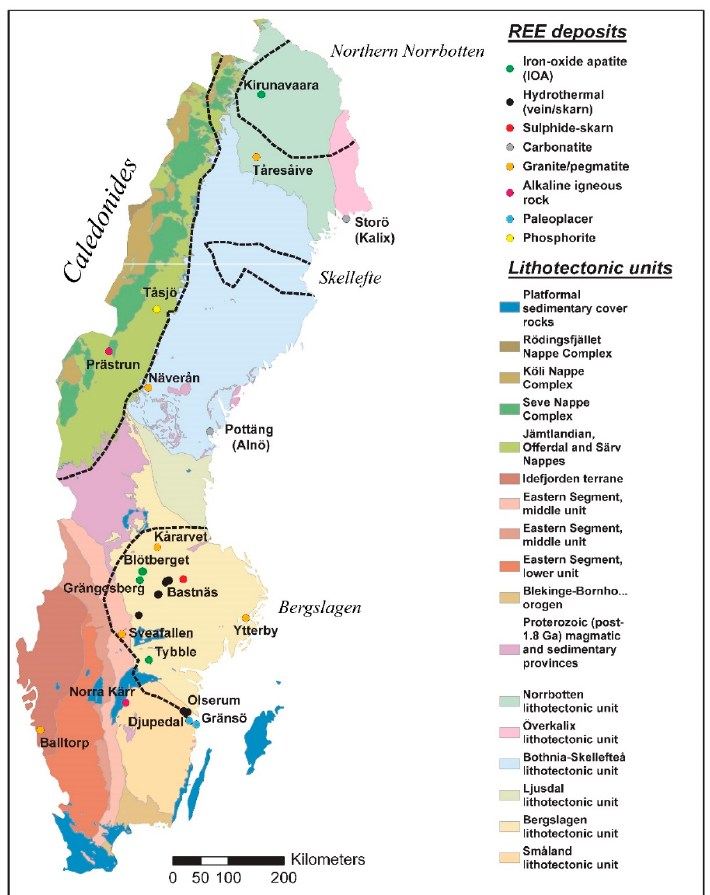
Figure 1. Simplified map of major lithotectonic units and ore districts in Sweden, with a selection of Rare Earth Elements (REEs) deposits, prospects, and occurrences (modified from [1] and bedrock database at Geological Survey of